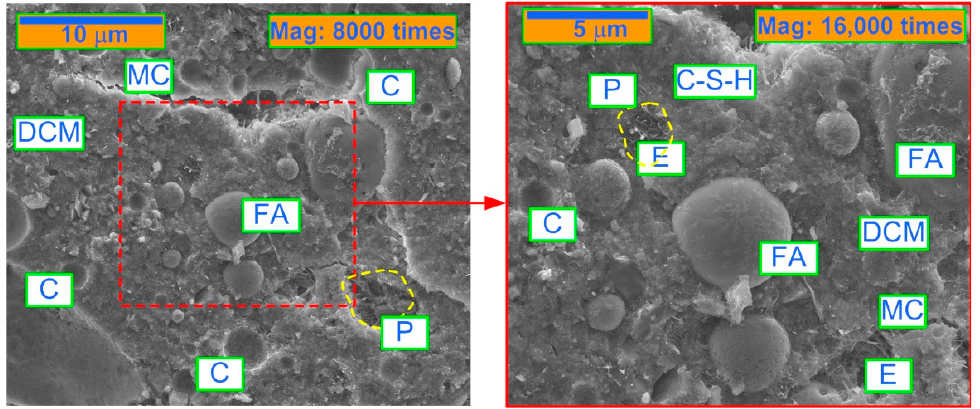
Figure 9. SEM microimages of analyzed T3 concrete; descriptions in the text.